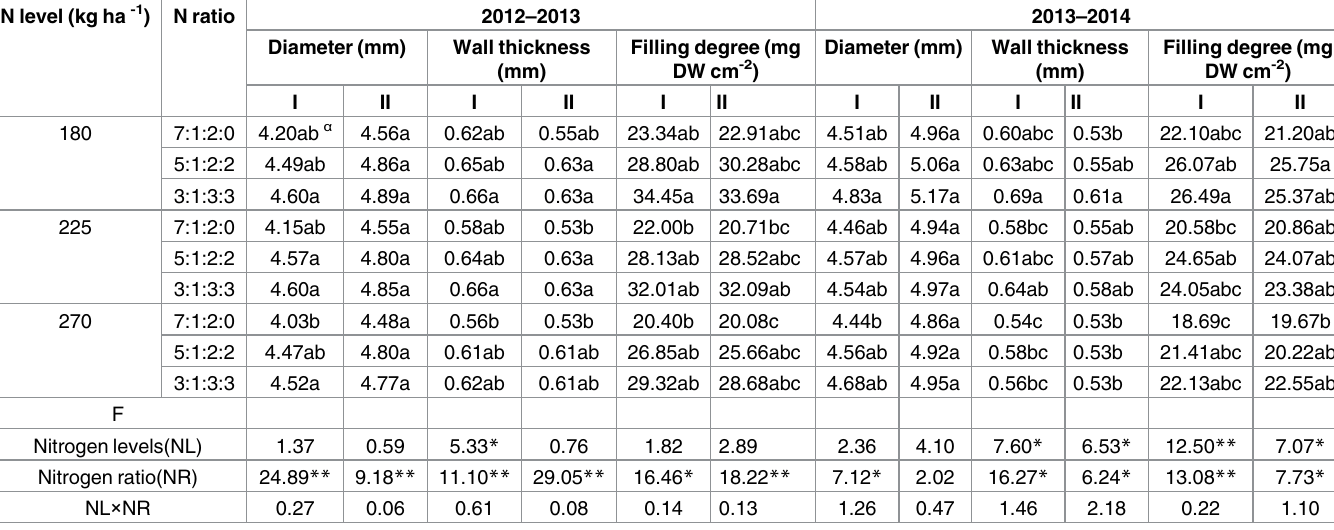
Table 4. Effect of nitrogen levels and ratios on diameter, wall thickness and filling degree of basal internodes. N level (kg ha -1 ) N